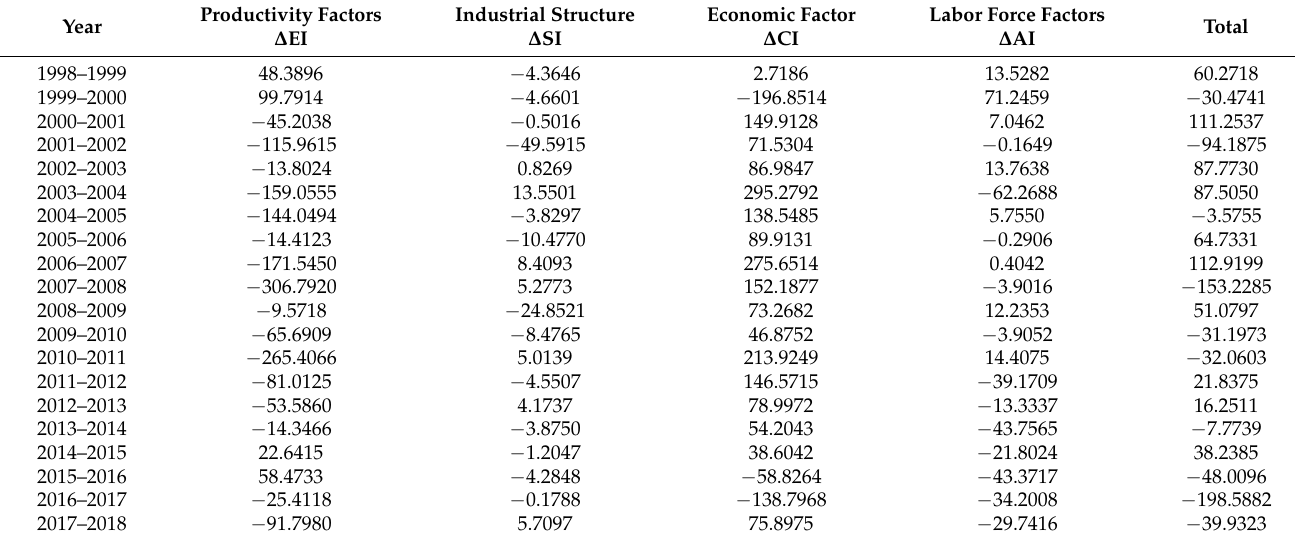
Table 6. Influential factors in agricultural carbon emissions in Jilin Province from 1998 to 2018. Productivity Factors Year ∆